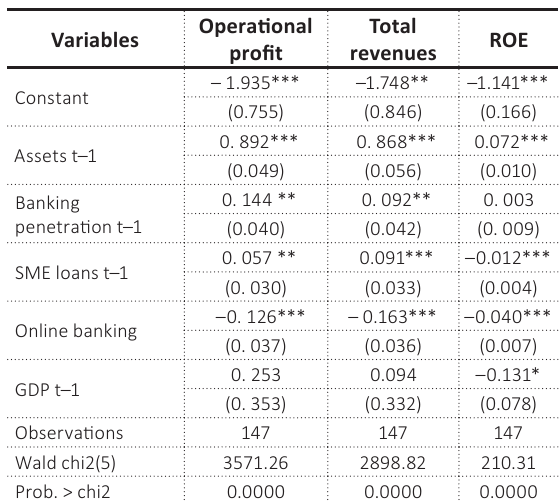
Table 5. GLS estimation